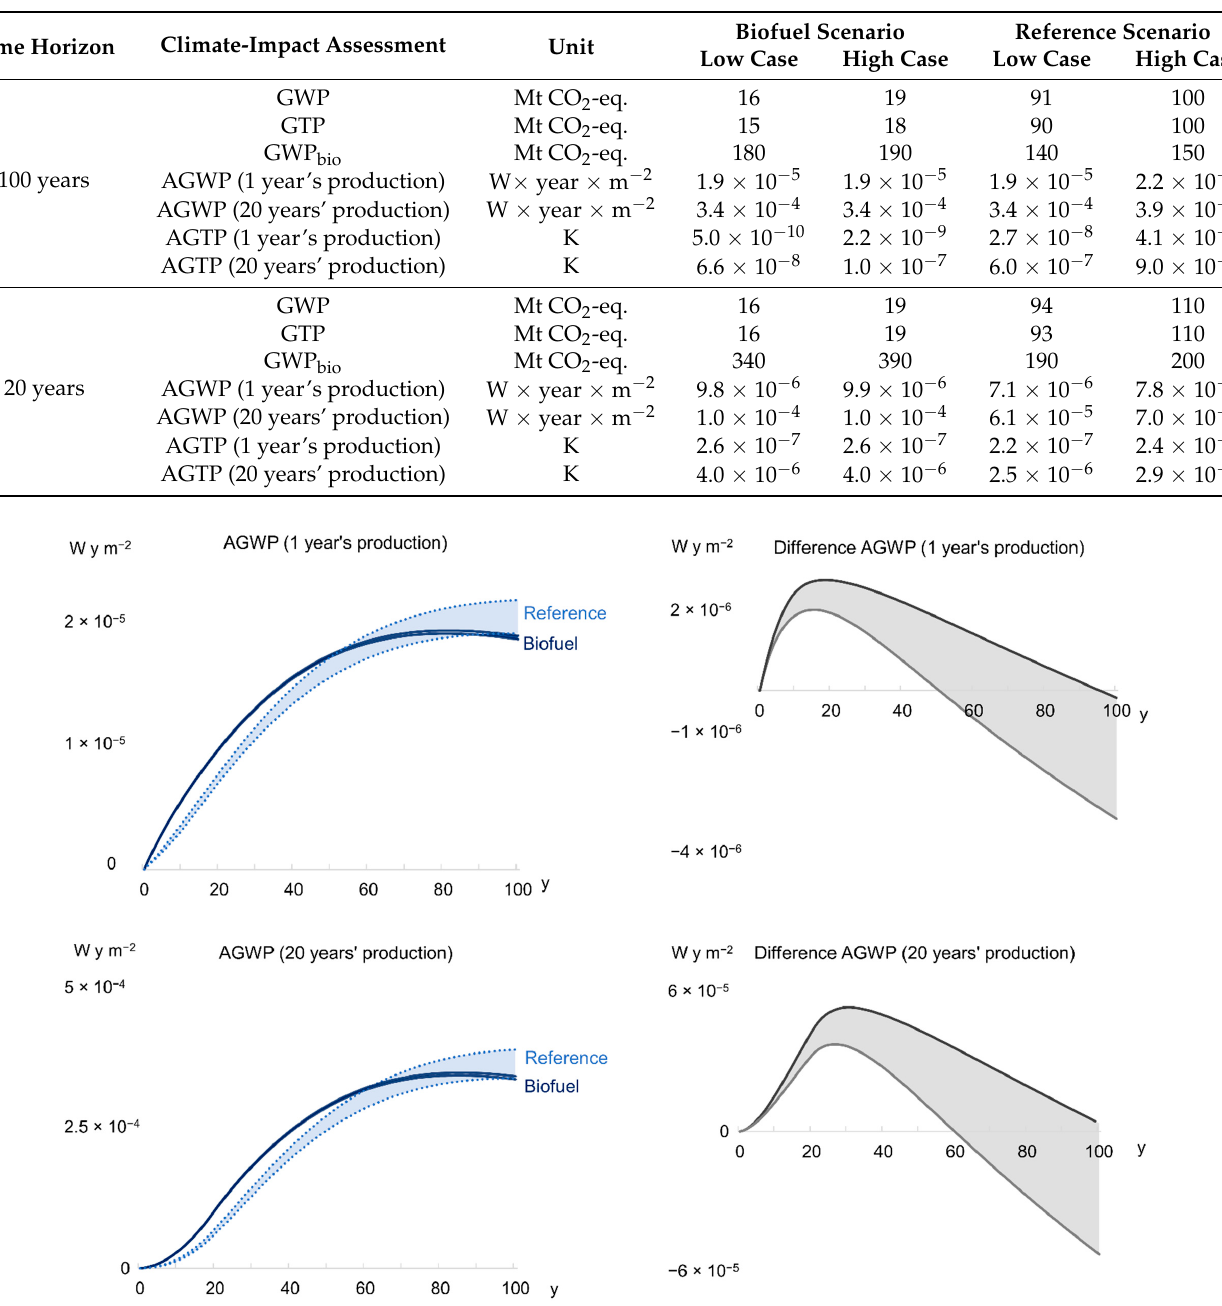
Table 3. Climate impact from handling of forest residues in the biofuel scenario and the reference scenario. The climate impact is calculated for utilization of 200,000 tonnes (t) DM (dry matter) logging residues, except in the cases of AGWP and AGTP calculations of 20 years’ production (utilization of 200,000 t DM logging residues each year for 20 consecutive years). Dark shading marks the scenario that results in higher climate impact, and light shading means that the climate impact of the two scenarios overlap.